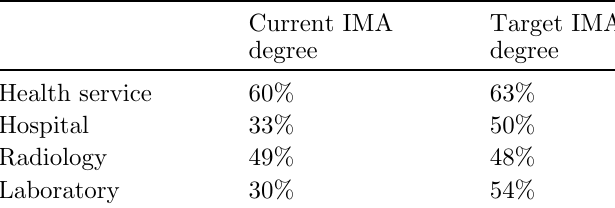
Fig. 6. Interaction model in e-health network.